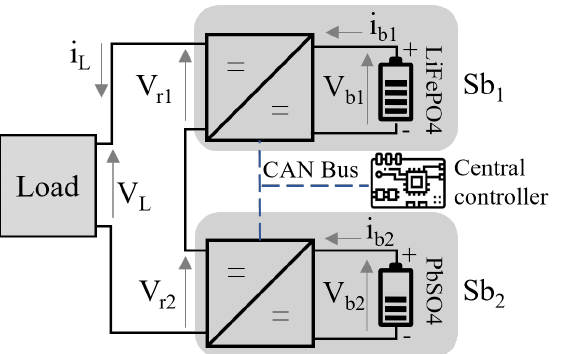
Figure 9. Testing bench diagram for the battery bank with active power flow control.